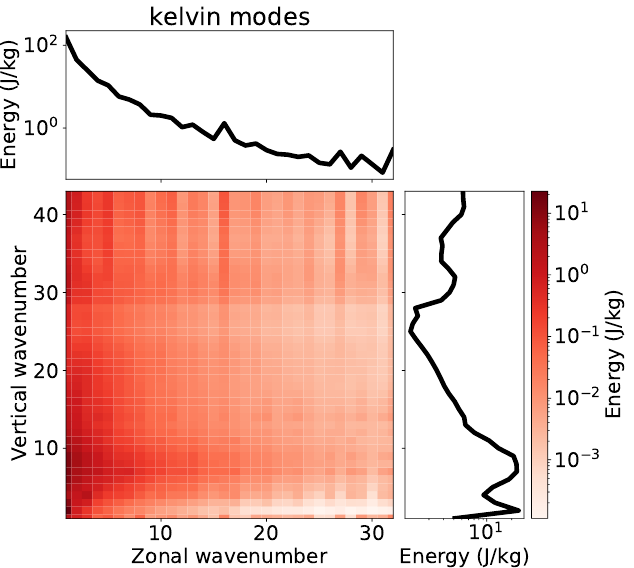
Figure 14. Energy spectrum of the Kelvin mode component of the atmospheric oscillations as a function of the zonal wavenumber and vertical mode.